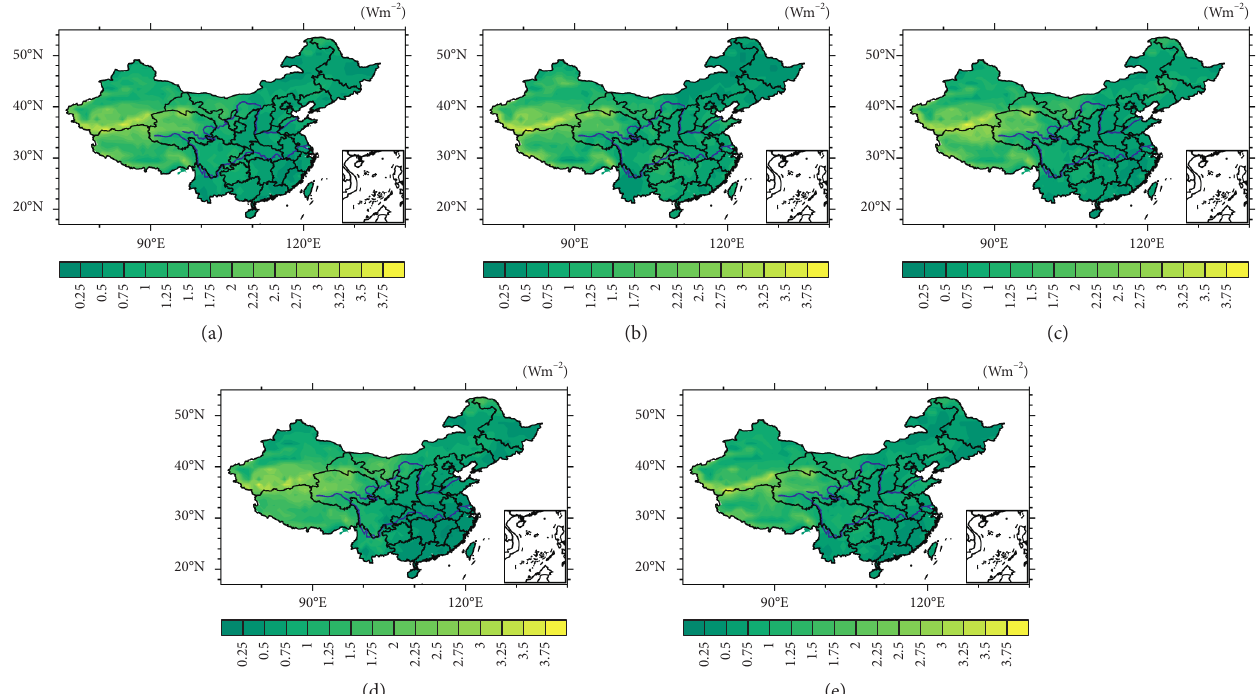
Figure 10: The difference of the ULR (Wm − 2 ) in China between the all-sky conditions and clear-sky conditions during 2001–2016: (a) annual, (b) spring, (c) summer, (d) autumn, and (e)